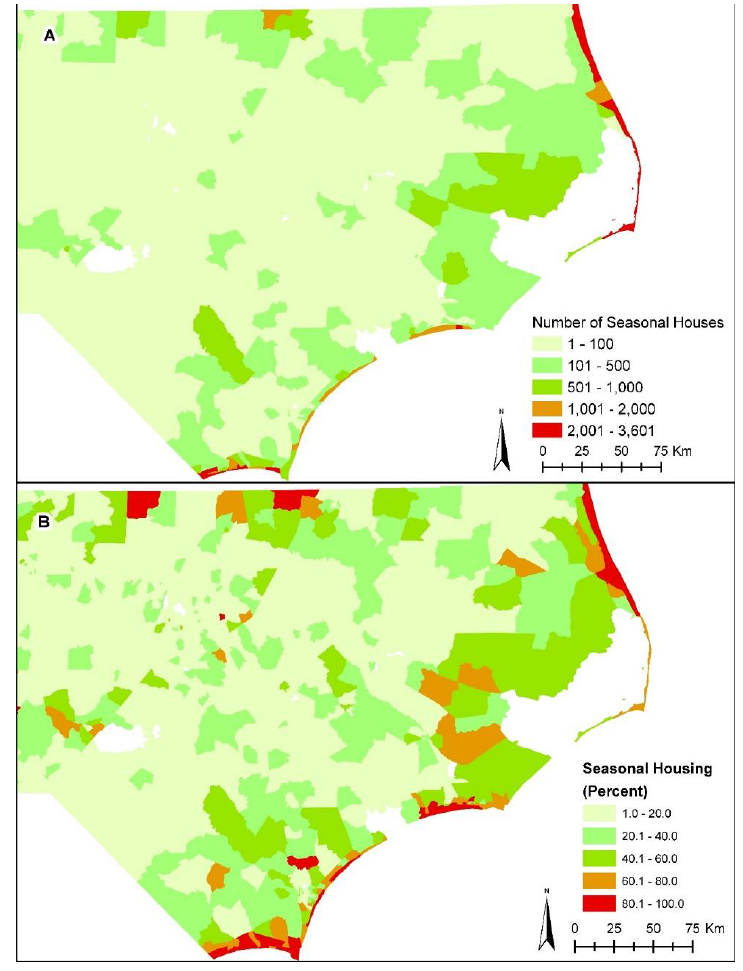
Figure 4. Number of seasonal houses (A) and percent seasonal housing (B), by Census Tract. Source: Census 2010 [35].